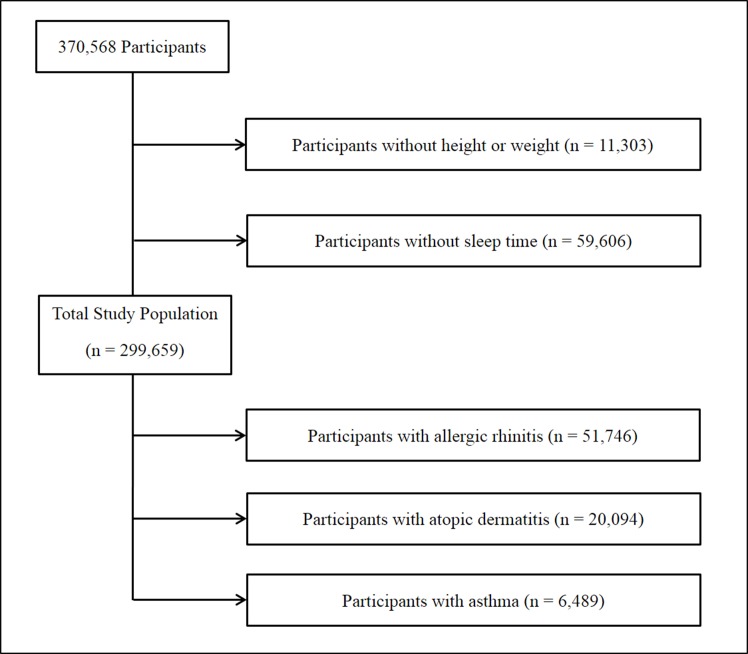
A schematic illustration of participant selection in the present study.Among a total of 370,568 participants, participants without information on height or weight (11,303), and sleep time or who sleep less than 2 hours (59,606) were excluded. The data for the 299,659 participants from whom complete data were obtained were analyzed.